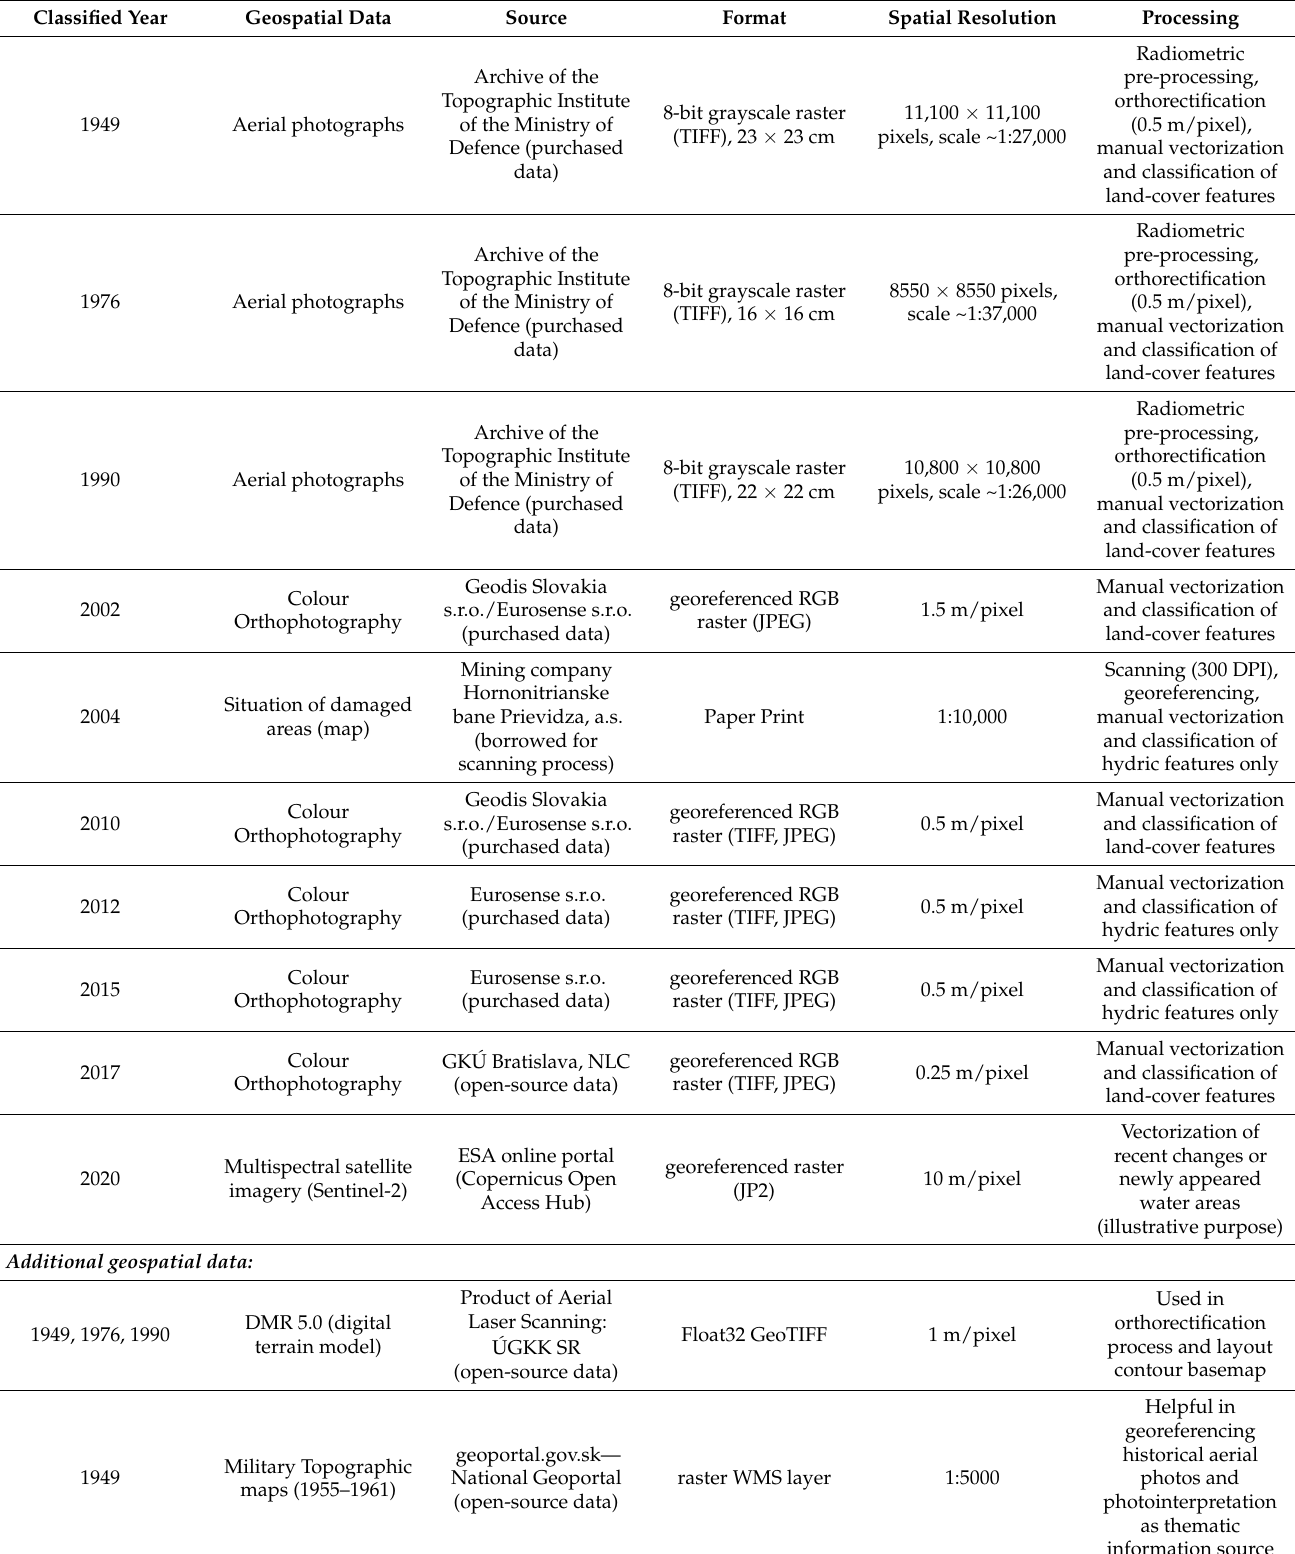
Table 1. Characteristics of geospatial data sources and processing for land-cover